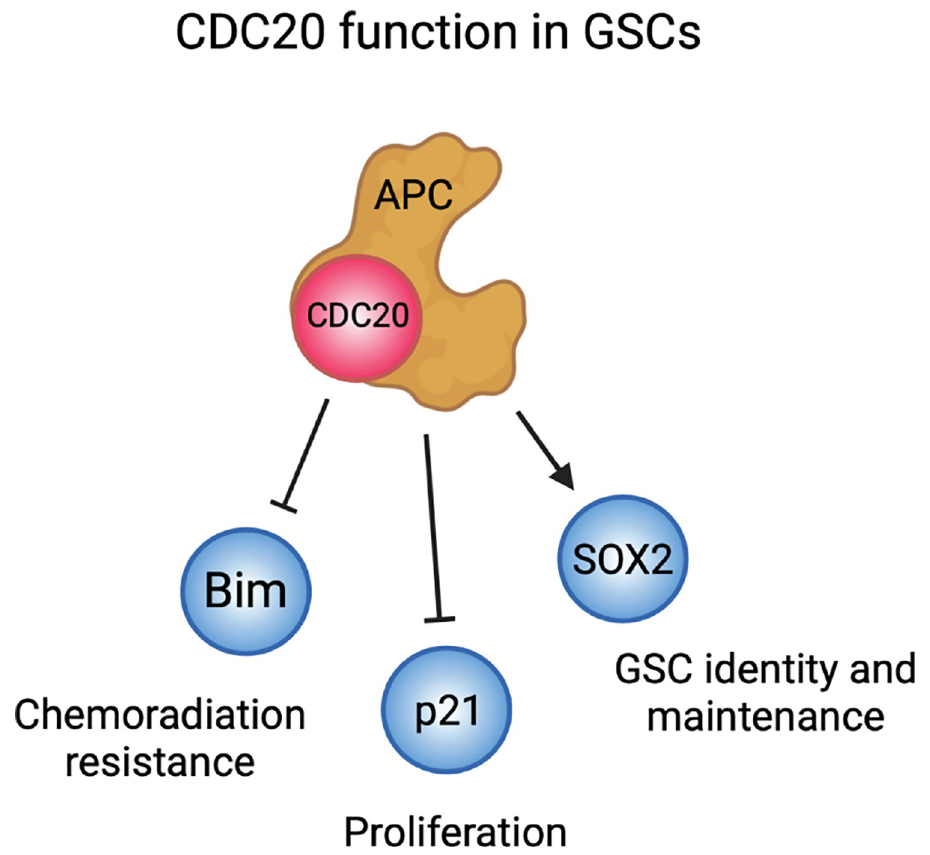
Fig 6. Mechanisms of CDC20-APC in GSCs. The current study identifies a role for CDC20-APC substrate Bim in GSC chemoradiation resistance. Other relevant substrates of CDC20-APC in GSCs include p21 (17) and SOX2 (12). Schematic created using